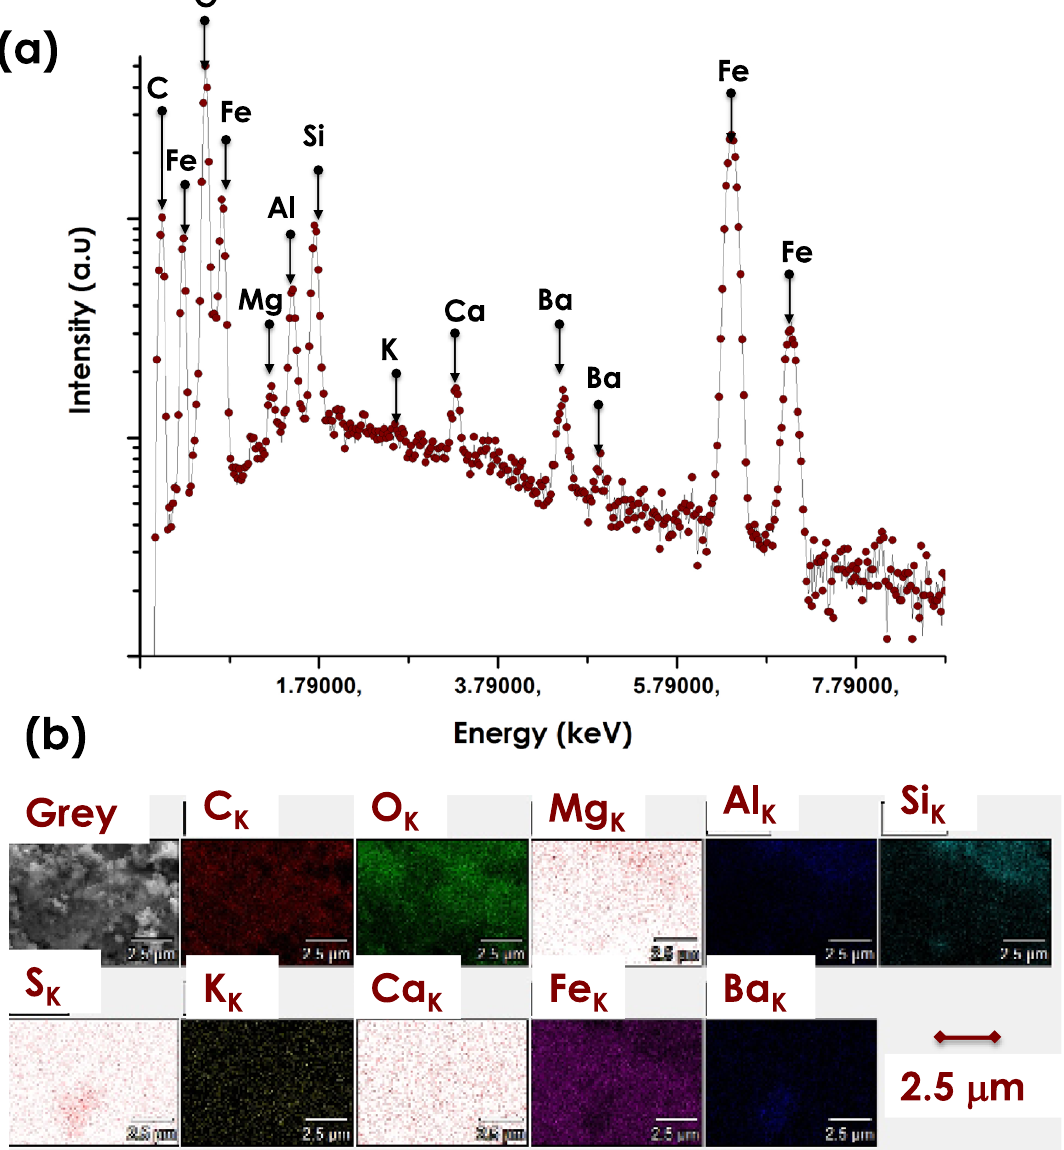
Figure 3. ( a ) EDS elemental spectrum of the Red Ochre pigment & ( b ) its corresponding 2-D disctribution scan of the various detected